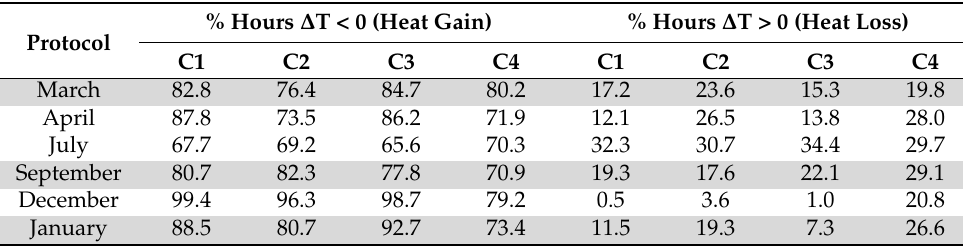
Table 5. Percentage of hours with positive or negative ∆ T.